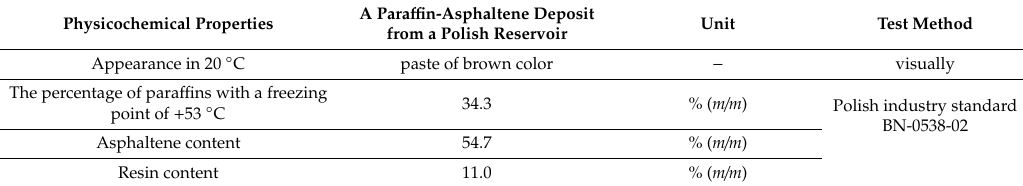
Table 4. Physicochemical properties of a para ffi n-asphaltene deposit from a Polish reservoir selected for the tests.